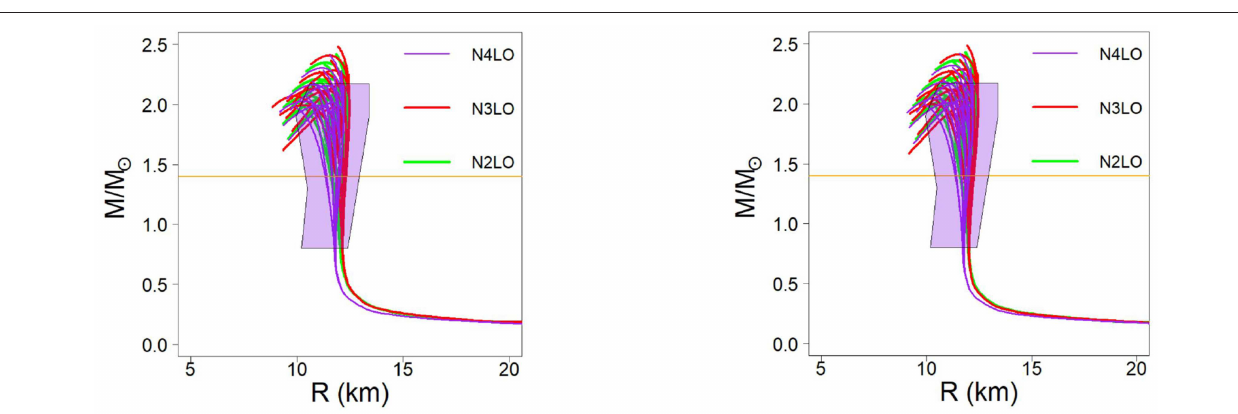
we can estimate a realistic uncertainty. We stress again that this procedure is a way to simulate the uncertainty arising from reasonable parameterizations of the EoS as